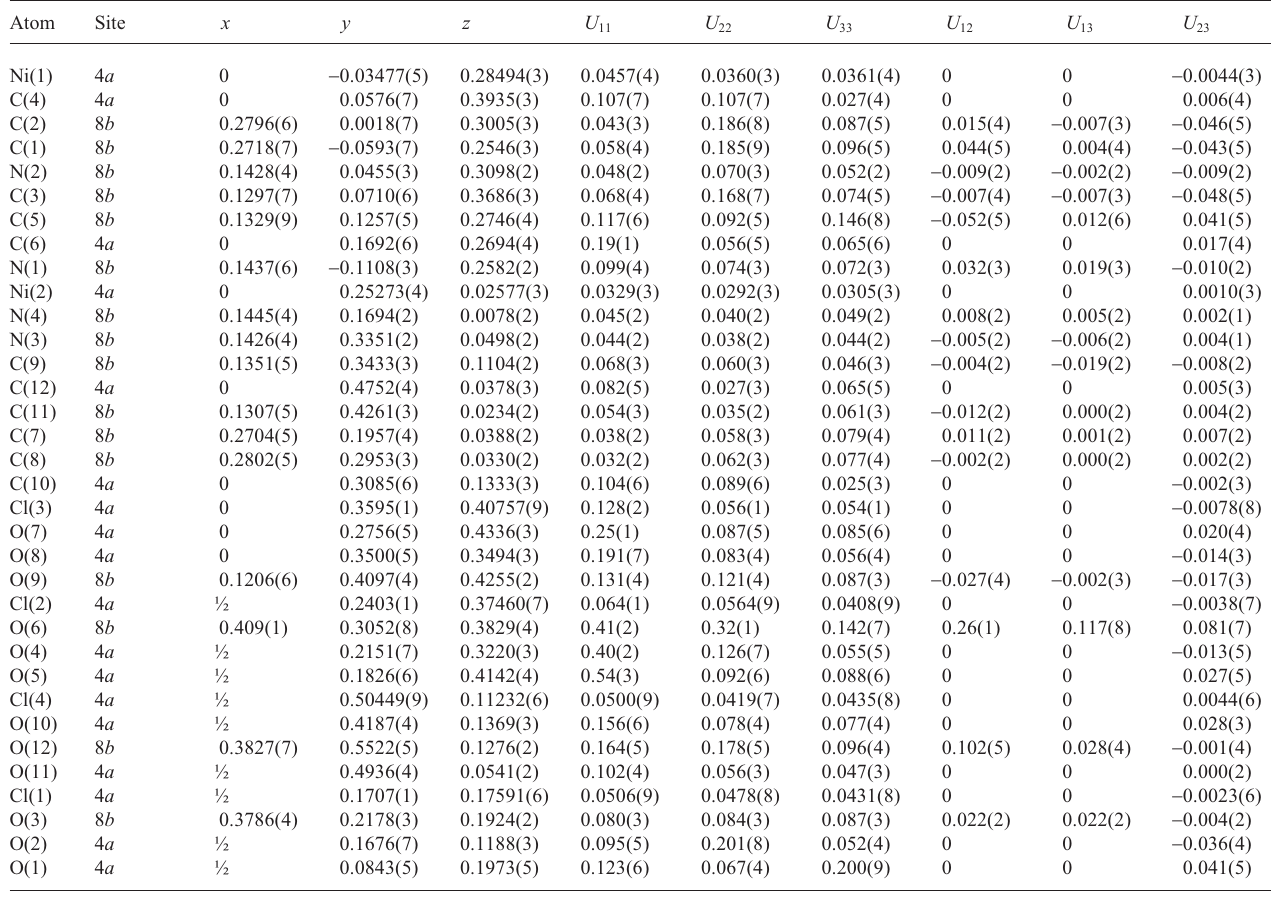
Table 3. Atomic coordinates and displacement parameters (in Å 2 )